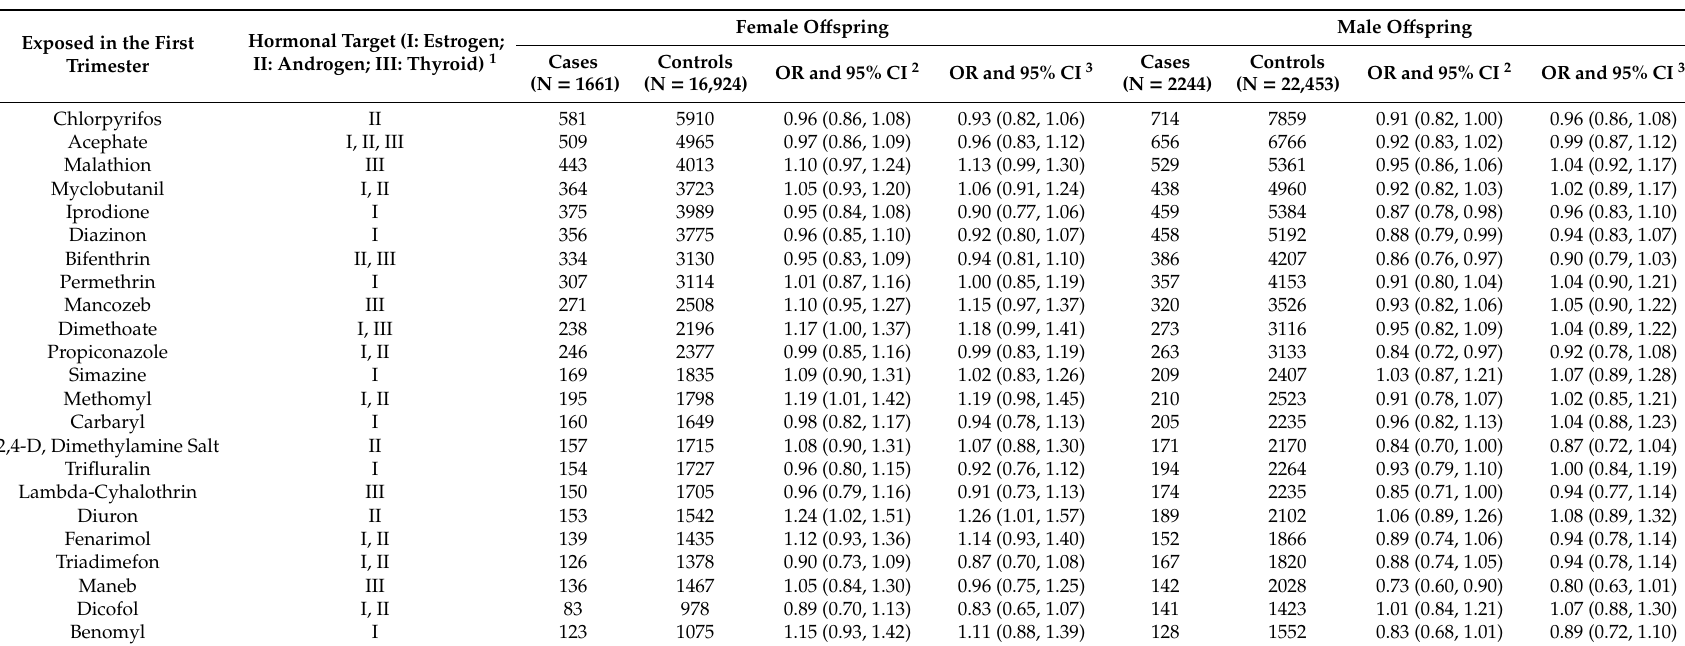
Table 4. OR and 95% CI for cerebral palsy according to first trimester exposure to each of the 23 pesticides compounds with suspected endocrine-disrupting properties. Exposed in the First